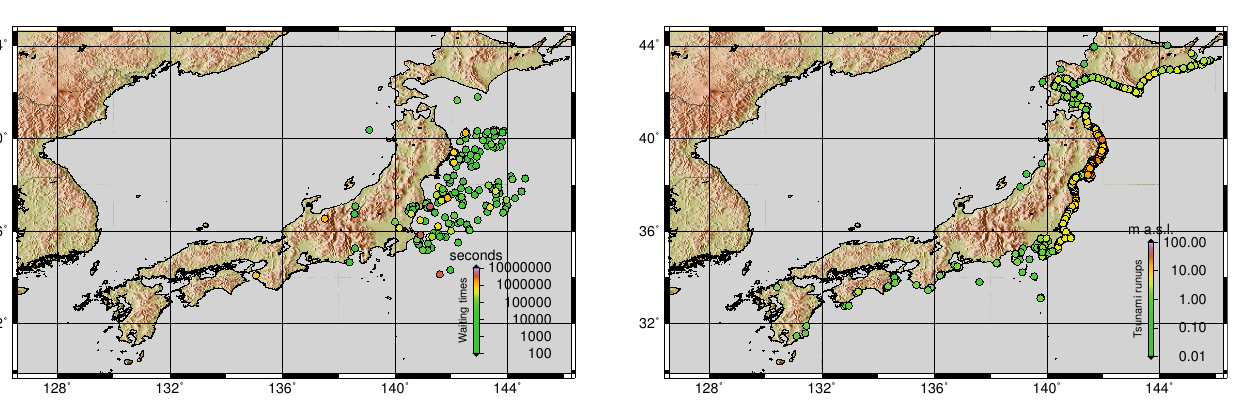
Figure 4. Selected events of the aftershock series, from 11 March 2012 until 31 January 2012, from the GCMT database (Ekström et al., 2012). The dynamical range of waiting times is at least 4 orders of magnitude.